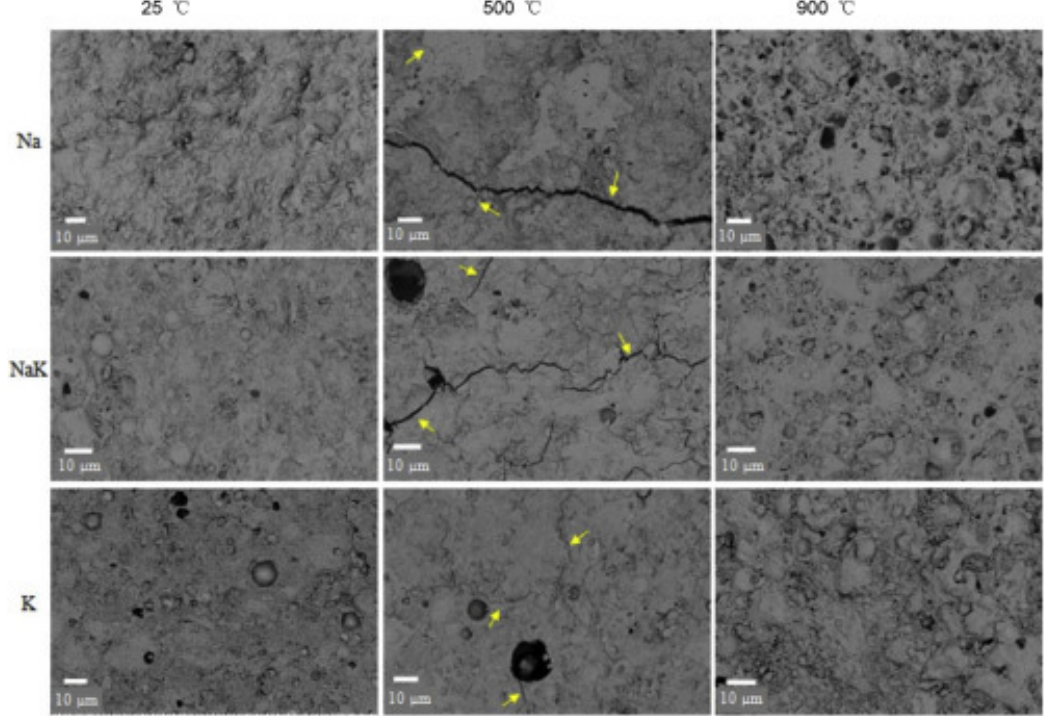
Figure 4. SEM-BSE micrographs depict the formation and healing of micro-cracks in geopolymer at various temperatures (solid arrows showing micro-crack). Reprinted/adapted with permission from [113]. 2018. Lahoti.